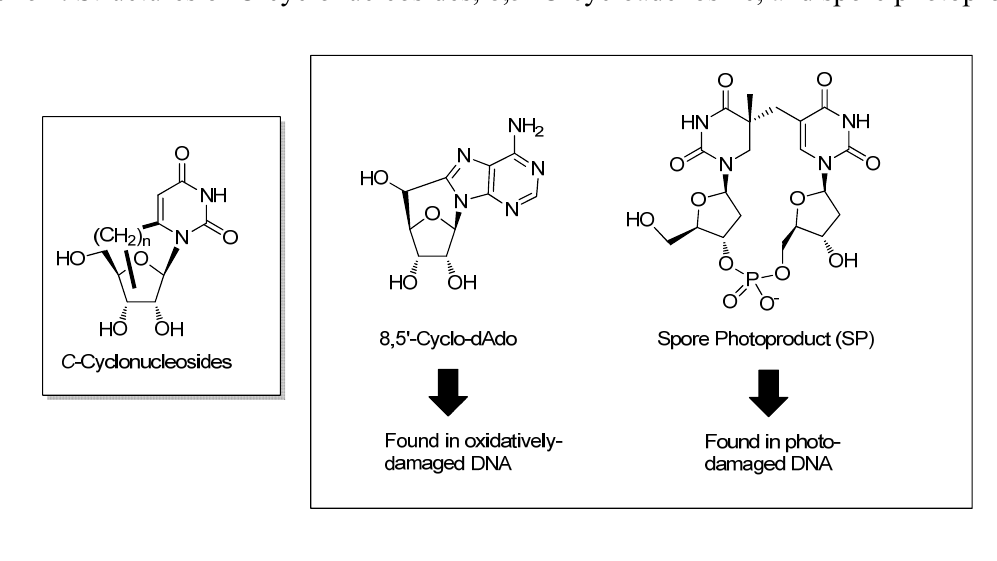
Figure 2. Structures of C -cyclonucleosides, 8,5 ′ - C -cycloadenosine, and spore